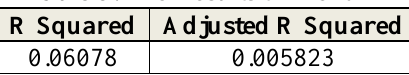
Table 9. The Results of R and R